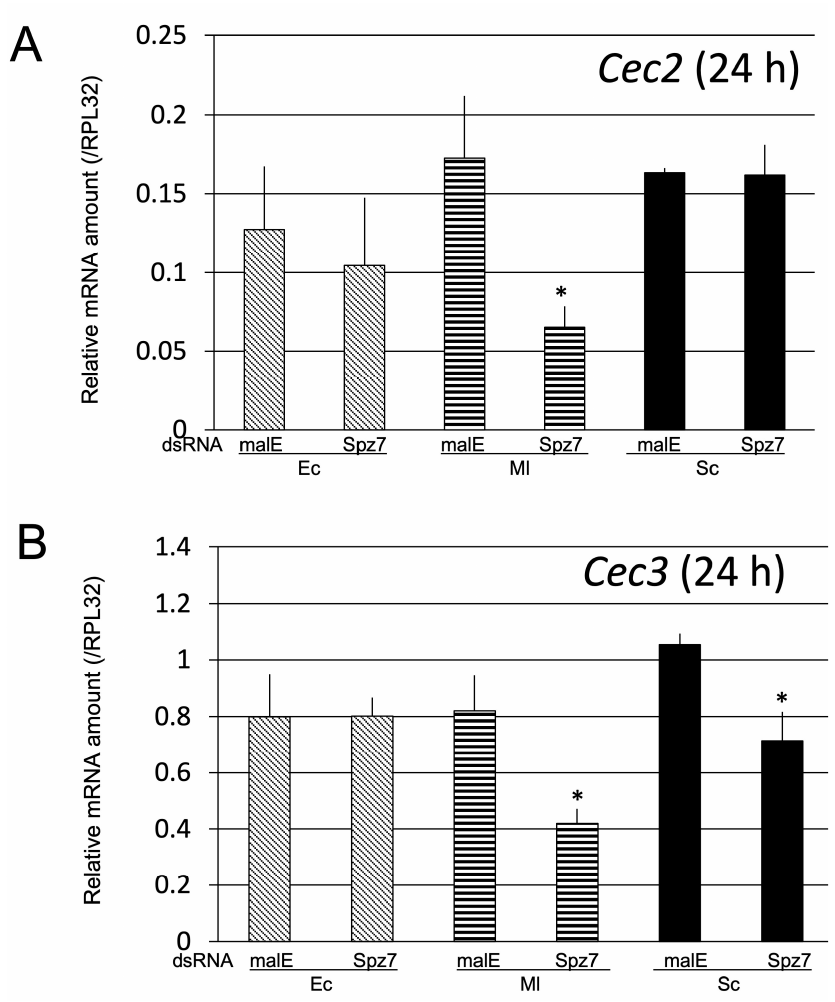
Figure 12. Effect of Spz7 knockdown on Cec2 ( A ) and Cec3 ( B ) induction at 24 h post-challenge. The mRNA levels of Cec2 ( A ) and Cec3 ( B ) in spz7 knockdown or control ( malE dsRNA-treated) pupae were measured. The detailed procedure was the same as that described in Figure 10. Experiments with three animals were independently repeated three times, and each column represents the mean ± S.D. Asterisks indicate p < 0.05 compared to malE dsRNA-treated control samples, according to Student’s t -test.